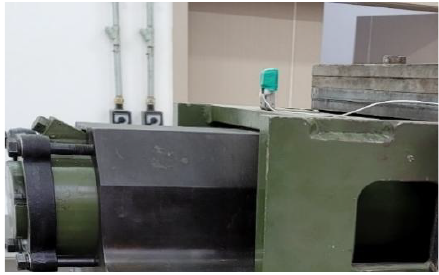
Fig. 6 . Acceleration sensor installation.